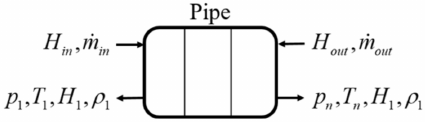
Figure 3. Interface parameters of pipe